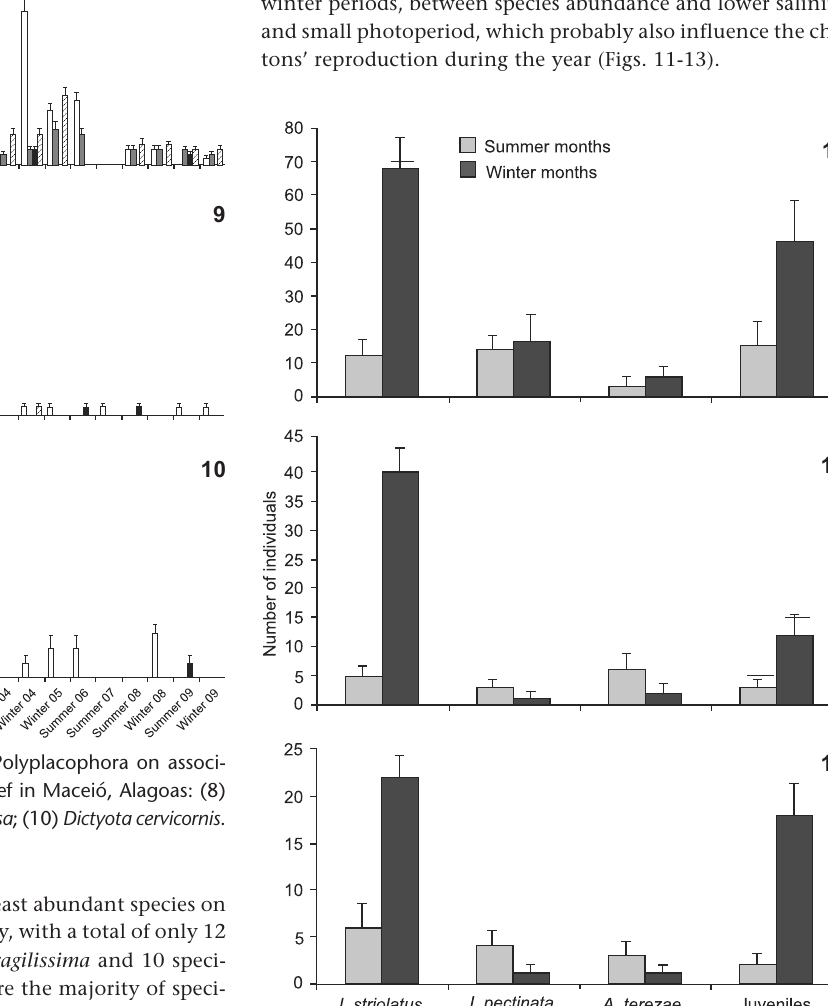
Figures 11-13. Summer and winter distribution of Polyplacophora on associated phytals of the Ponta Verde coral reef in Maceió, Alagoas: (11) Amphiroa fragilissima ; (12) Caulerpa racemosa ; (13) Dictyota cervicornis